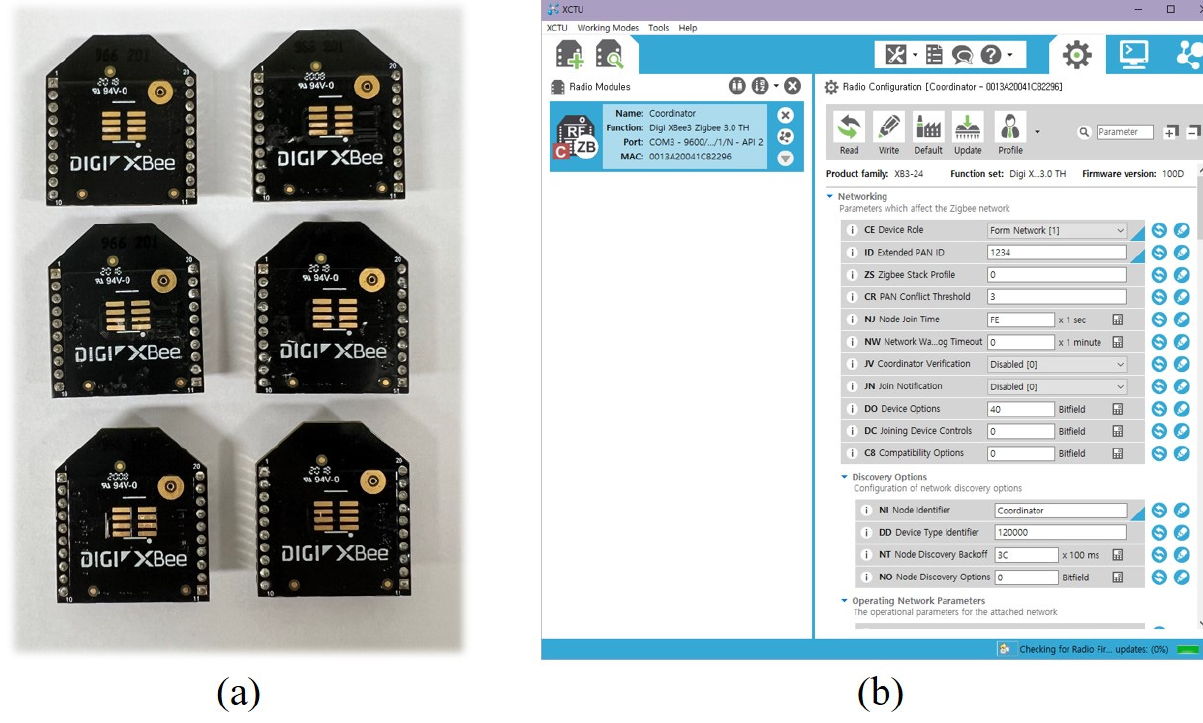
Figure 2. ( a ) XBee 3 Pro module s and ( b ) XCTU application for XBee